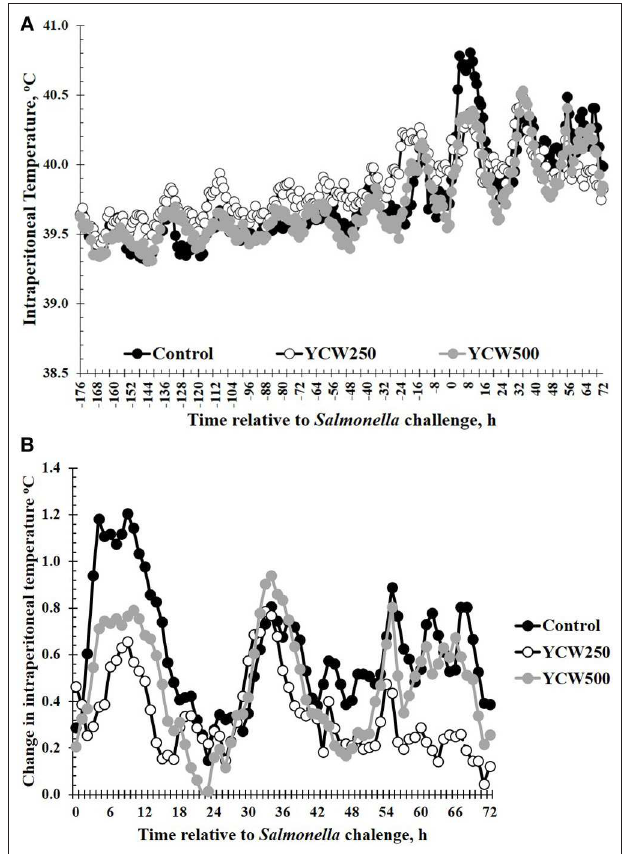
FIGURE 2 | (A) The intraperitoneal temperature response and (B) change in intraperitoneal temperature in pigs fed a control (Control) diet or supplemented with a yeast cell wall at 250 mg/kg (YCW250) or 500 mg/kg (YCW500), following administration of an oral Salmonella Typhimurium challenge on d 19. (A) SEM ± 0.12 ◦ C for all treatment groups; (B) SEM ± 0.01 ◦ C for all treatment groups.